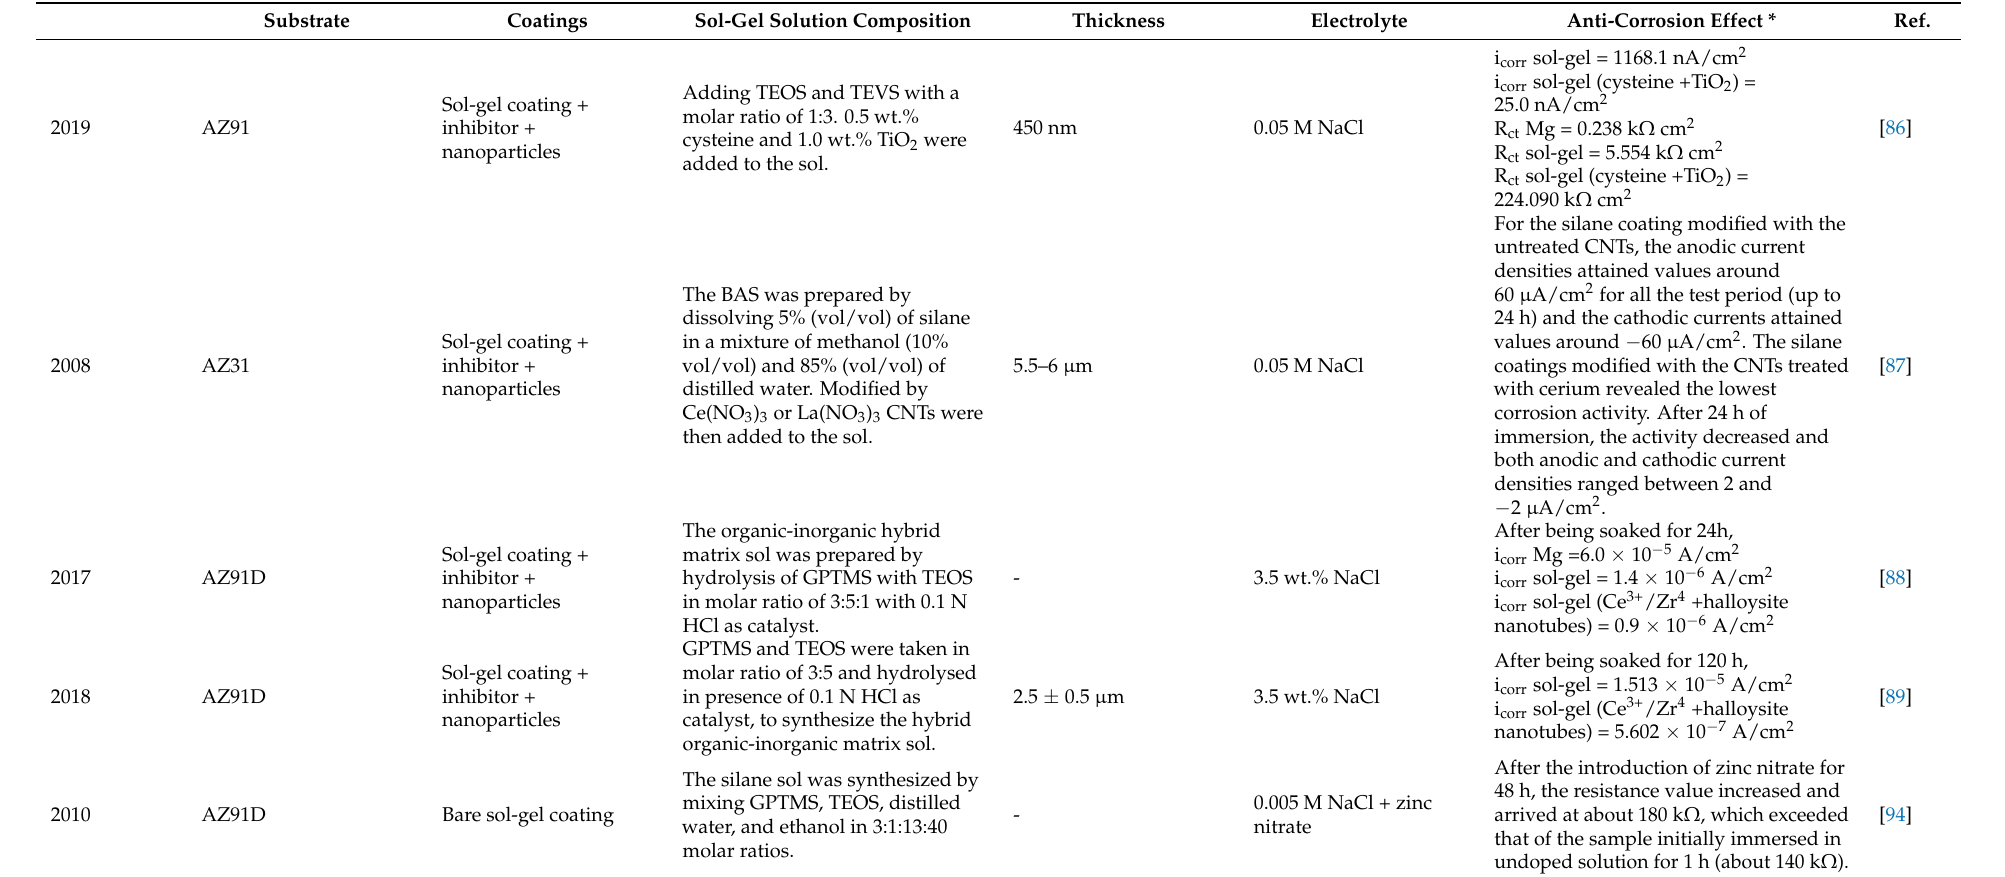
Table 3. Cont. Substrate Coatings Sol-Gel Solution Composition Thickness Electrolyte Anti-Corrosion Effect *